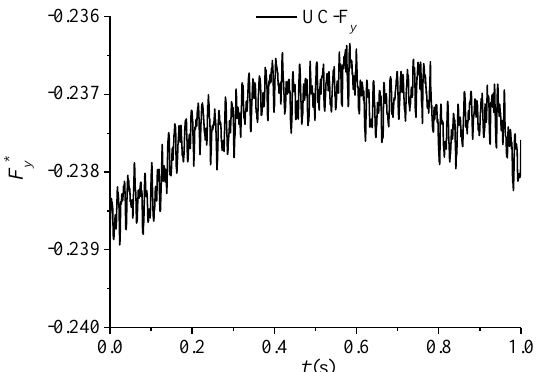
quency domain diagram of UCO-F y .